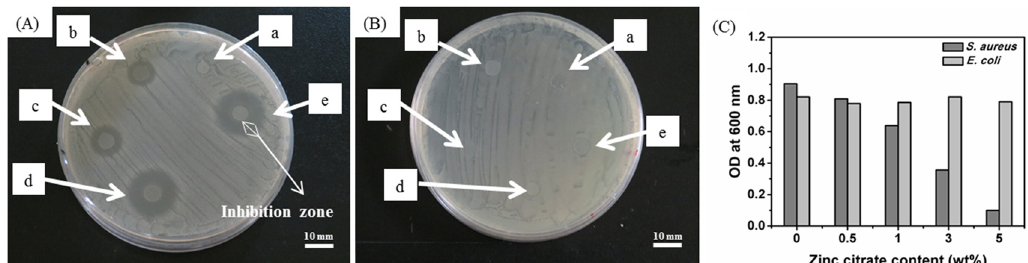
Figure 7. The antibacterial efficacy of PVA/zinc citrate nanofiber mats against ( A ) S. aureus ; ( B ) E. coli and ( C ) optical density. The mats are composed of ( a ) 0 wt %, ( b ) 0.5 wt %, ( c ) 1 wt %, ( d ) 3 wt %, and ( e ) 5 wt % zinc citrate. Table 3. The antibacterial efficacy of PVA/zinc citrate nanofiber mats against S. aureus. Concentration Sample